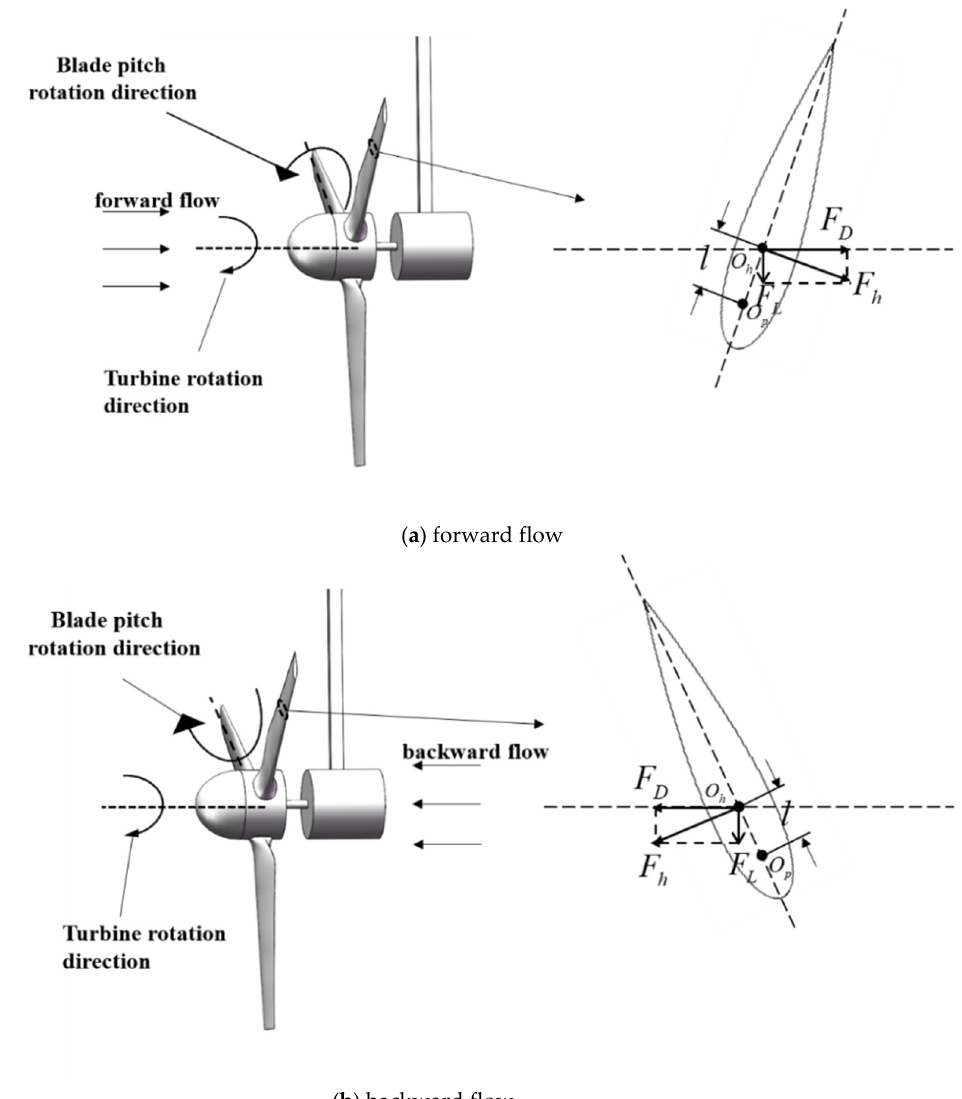
Figure 3. The principle of adaptive variable pitch in bidirectional flow.